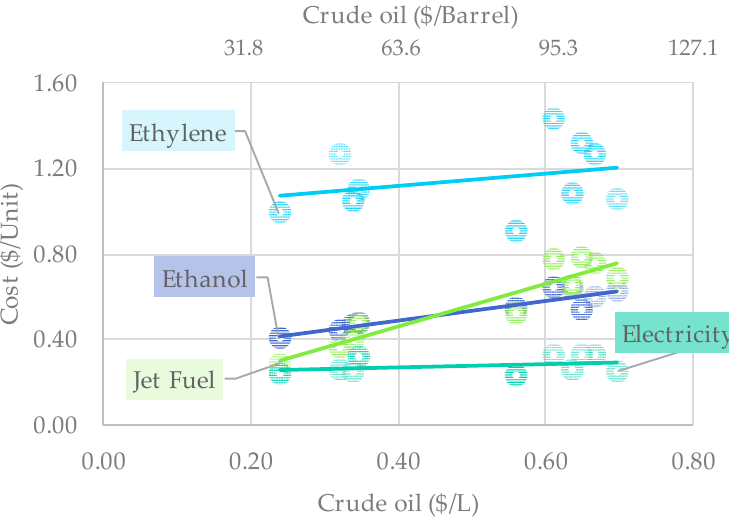
Figure 10. A historical comparison of the unit cost of electricity, jet fuel, ethanol and ethylene in relation to crude oil from 2007 to 2016. The primary horizontal axis shows crude oil as $/L, while the secondary horizontal axis shows the crude oil as $/Barrel to ease understanding.